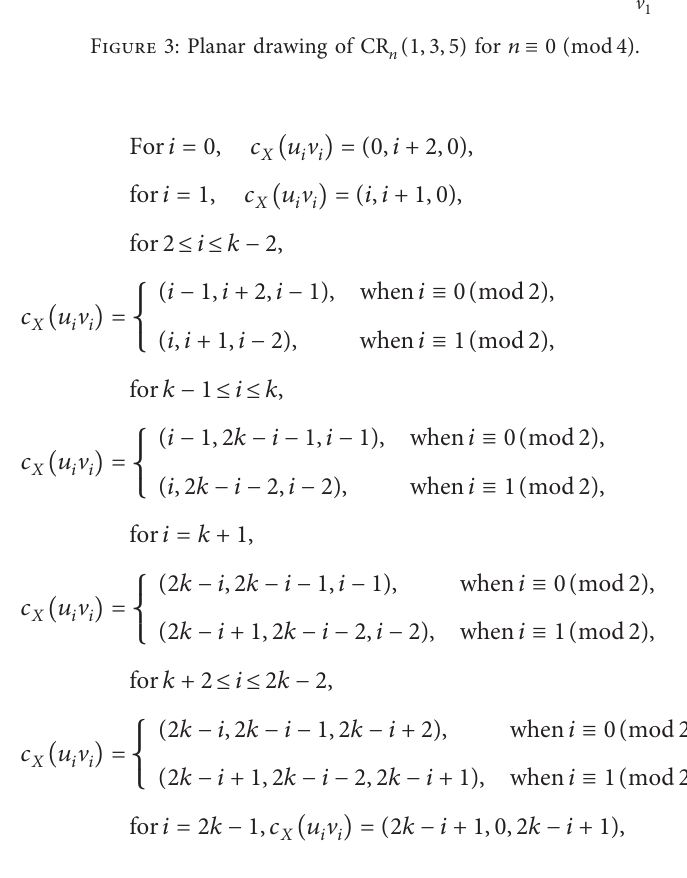
Figure 3: Planar drawing of CR